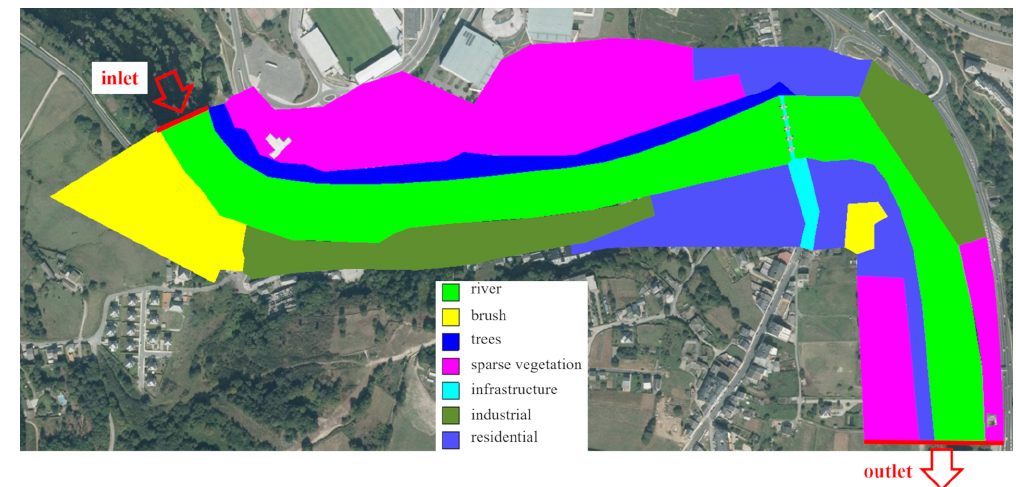
Figure 5. Numerical domain at Lugo. The land uses and the location of the boundary conditions (red lines) are also shown (PNOA courtesy of © Instituto Geográfico